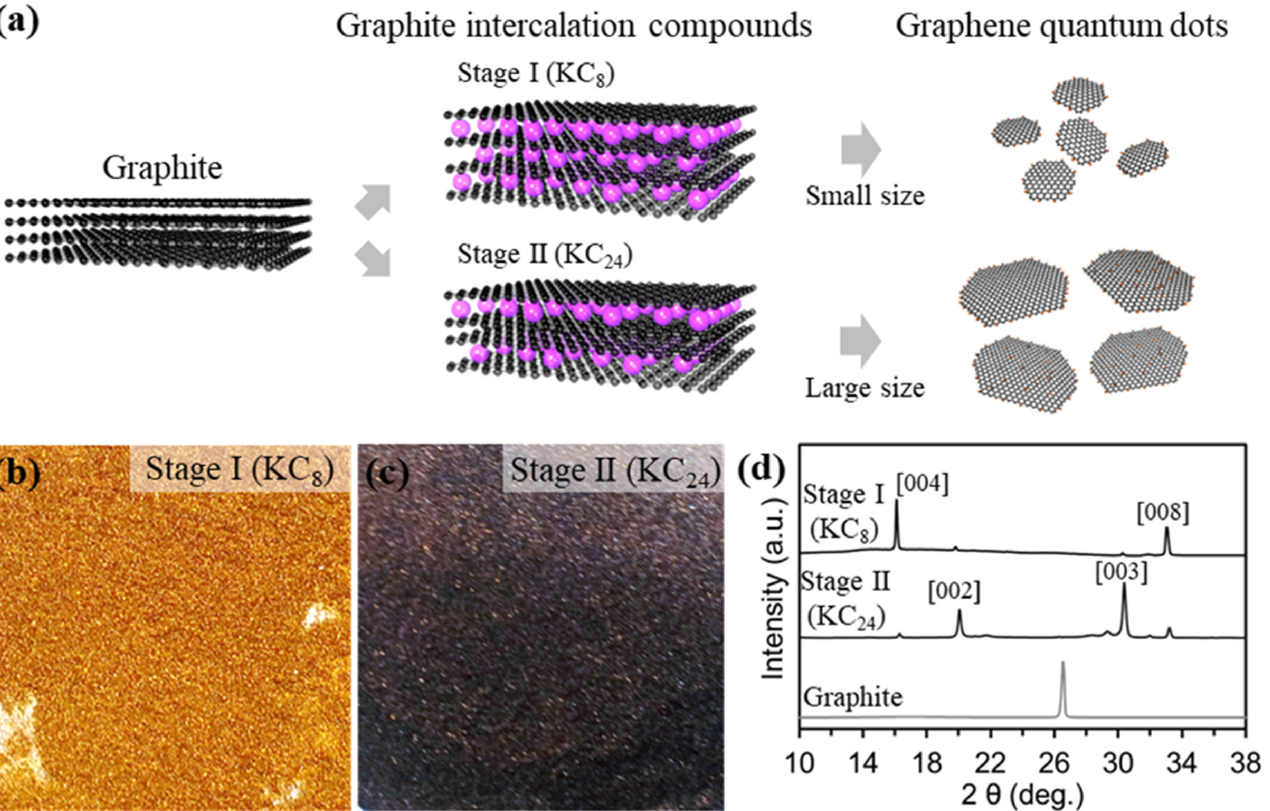
Figure 1. Schematic illustration and characterizations for graphene quantum dots ( a ), fabrication step of GQDs with different sizes QDs. ( b,c ), Digital images of stage I (KC 8 , left) and stage II (KC 24 , right). ( d ), XRD patterns of graphite, KC 8 , and KC 24 .